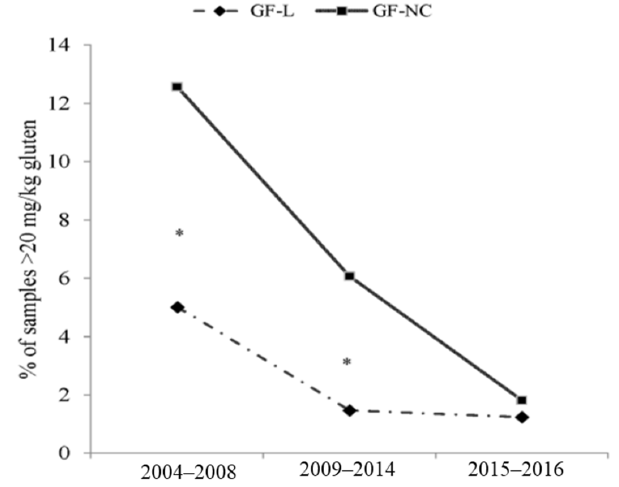
Figure 2. Evolution of gluten ‐ containing samples (>20 mg/kg) sorted by three time periods related to gluten regulation (2004–2008, 2009–2014, and 2015–2016). From the total number of 2614 samples, 1652 were gluten ‐ free ‐ labeled products (GF ‐ L) and 962 reportedly gluten free, but not certified, products (GF ‐ NC). Data are expressed as percentages of the total sample analyzed in each period. Significantly different time period are expressed as * ( p < 0.05).